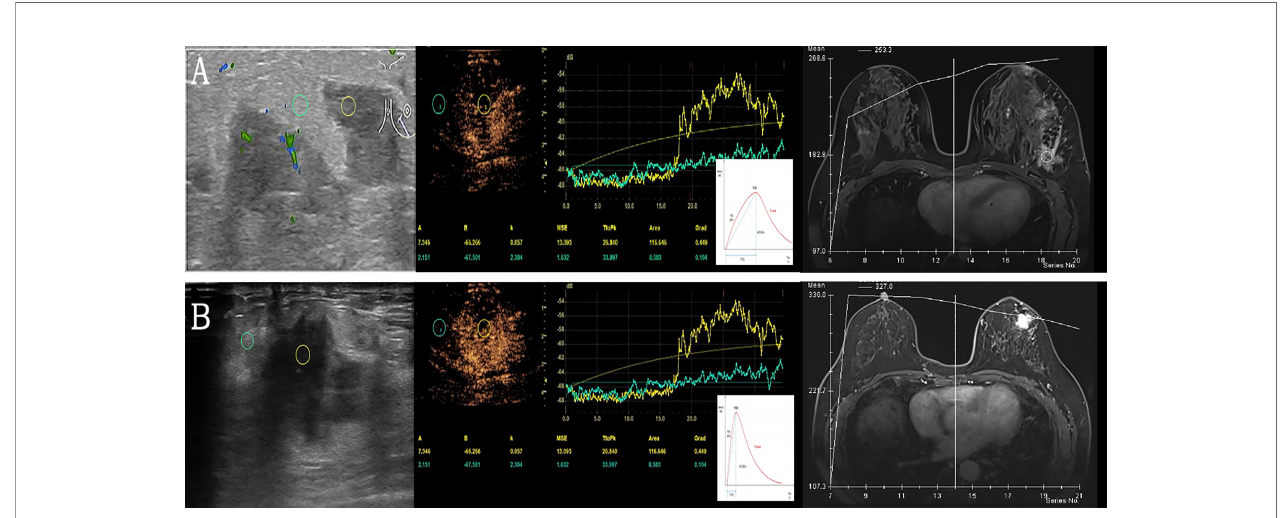
FIGURE 3 | Examples of quantitative data acquisition using ROI. (A) Granulomatous lobular mastitis in a 28-year-old female. Moderate enhancement of the lesion (yellow ROI) compared to minimal enhancement in surrounding breast tissue (green ROI). Gradual enhancement and a gradual wash out of contrast agent (corresponding TIC below) versus TIC of DEC-MRI. (B) Invasive ductal carcinoma in a 61-year-old female with signi fi cant enhancement of the lesion (yellow ROI) compared to slight enhancement in surrounding breast tissue (green ROI), the lesion is ill-de fi ned. After rapid enhancement of the tumor, early wash-out can be observed (corresponding TIC below) versus TIC of DEC-MRI. ROI, region of interest; TIC, time intensity curves; DEC-MRI, dynamic contrast enhancement magnetic resonance